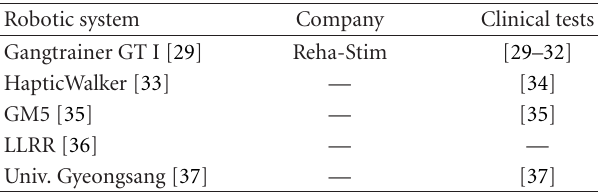
Table 2: Foot-plate-based robotic systems.